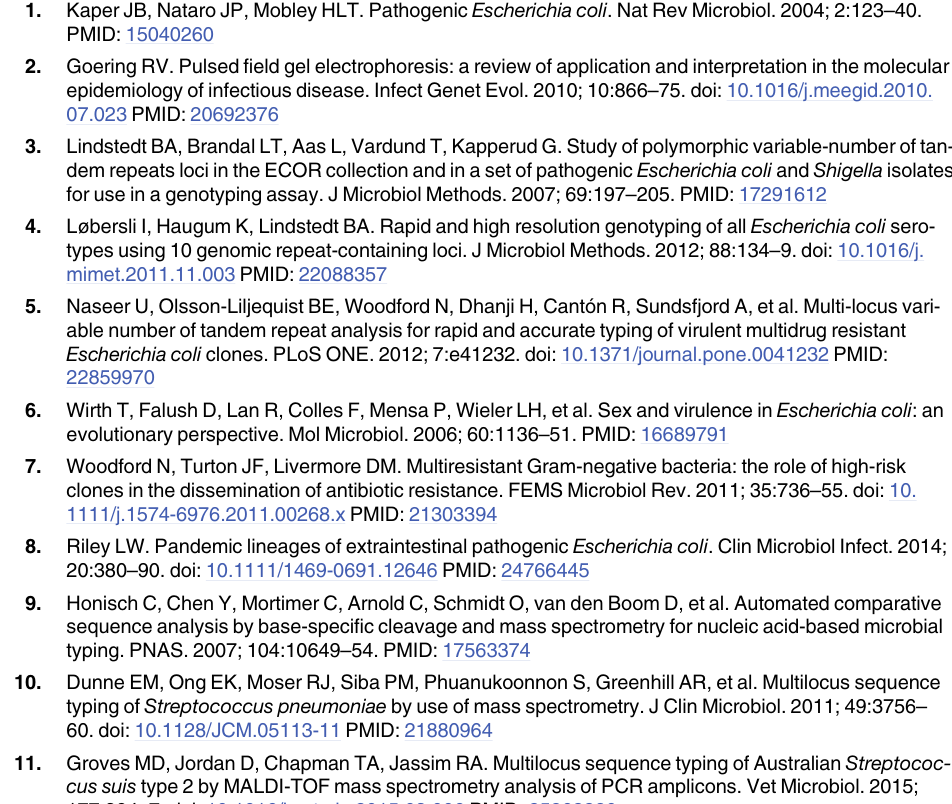
S1 Table. Primers used in this study. S2 Table. Simulation results for all seven Escherichia coli MLST alleles. S3 Table. gyrB allele pairs that differ by 10,290 Da